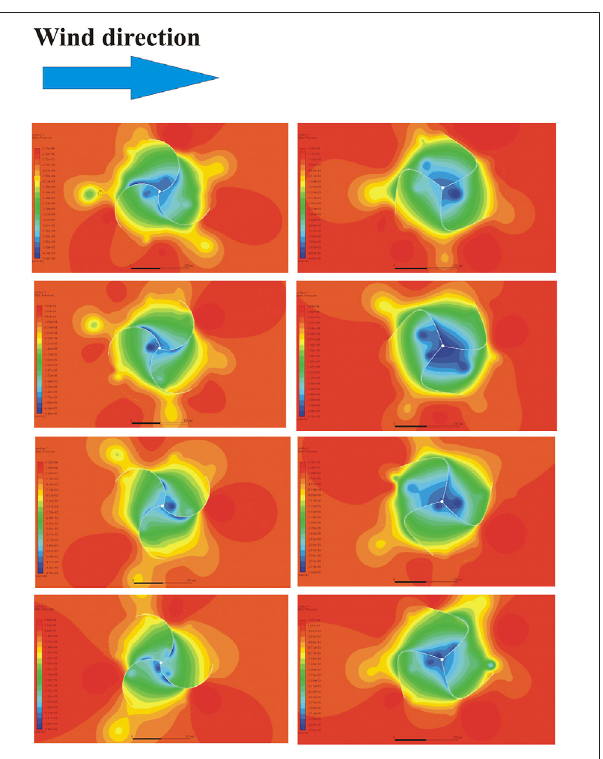
FIGURE 9 | Velocity contours of the optimized con fi guration compared to the original turbine.